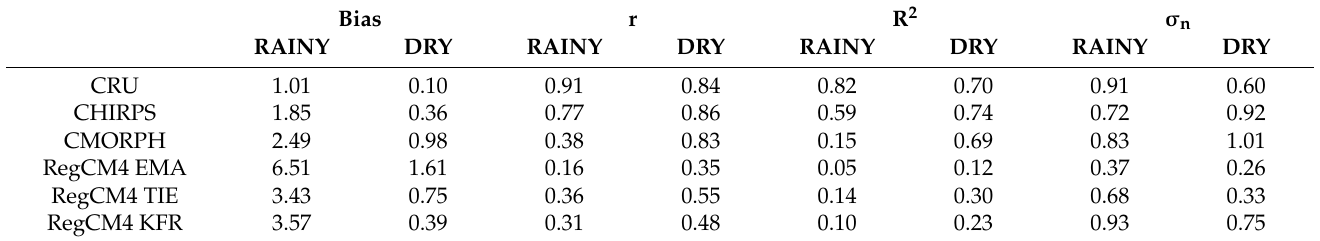
Table A2. Bias, correlation coefficient r, coefficient of determination R2, and normalized standard deviation σ n in RAINY and DRY regimes calculated between PREC station data and the observational bases (CRU, CHIRPS, and CMORPH) and RegCM4 simulations (EMA, TIE, and KFR). Bias r